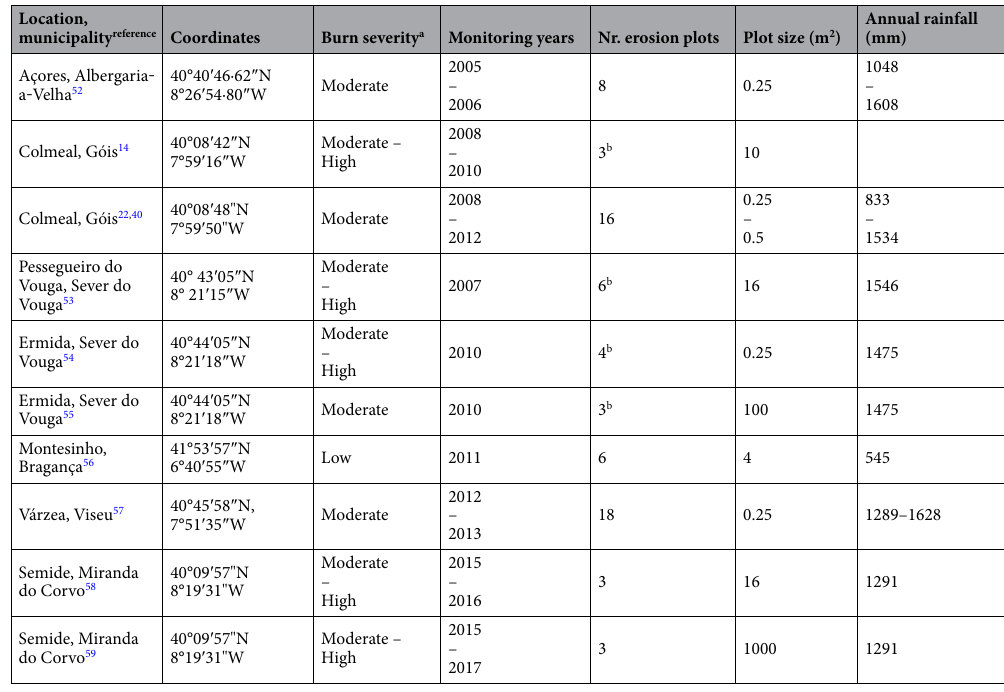
Table 2. Description of the field sites and experimental designs used for validation of post-fire soil erosion predictions by MMF. (a) Authors classification and/or according to Vega et al . 60 when unavailable; (b) Only control plots used, since the original study tested mitigation